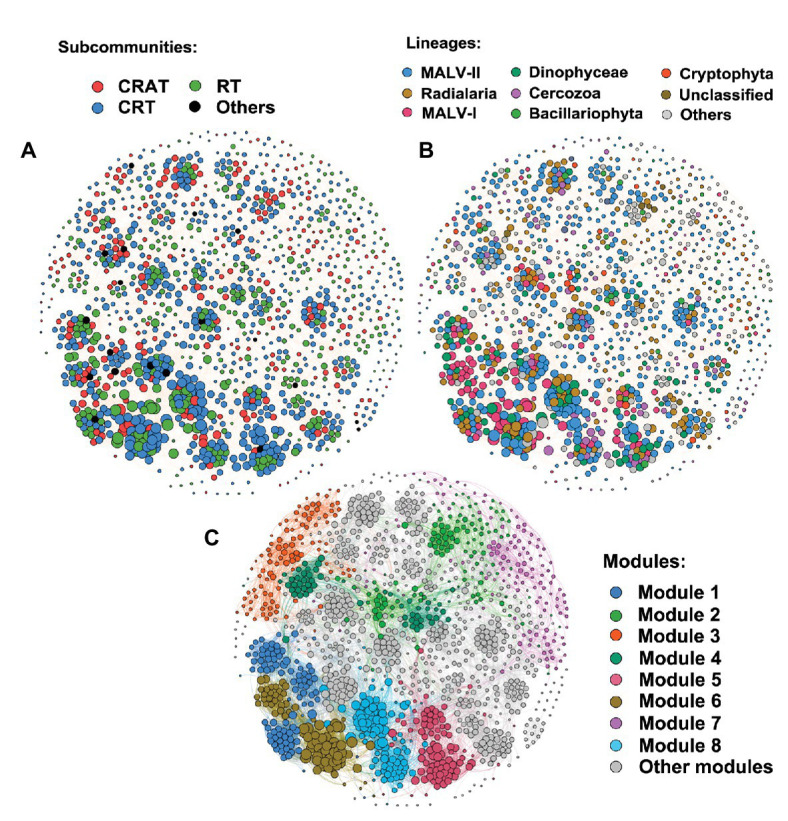
Co-occurrence networks among OTUs of protist community. The nodes were colored according to different categories of sub-communities (A), taxonomic lineages (B), and modules (C). Connections between two individual nodes stand for strong (Spearman’s r > 0.6 or r < −0.6) and significant (p < 0.05) correlation. The size of each node is proportional to the number of connections (i.e., degree).